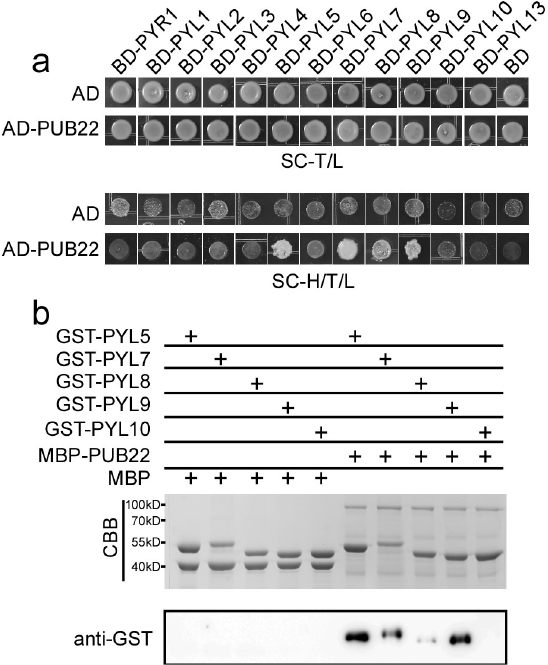
Figure 7. PUB22 interacts with PYL5, PYL7, PYL8, and PYL9. ( a ) PUB22 interacts with PYL5, PYL7, PYL8, and PYL9 in yeast two-hybrid assay. The combinations of PUB22 with different PYLs were grown on the SC medium lacking Tryptophan and Leucine (SC-T/L) or Tryptophan, Leucine and Histidine (SC-H/T/L). ( b ) PUB22 interacts with PYL5, PYL7, PYL8, and PYL9 in the pull-down assay. MBP-PUB22 and MBP bound with Amylose resin were incubated with GST-PYL5, GST-PYL7, GST-PYL8, or GST-PYL9, separately. Five percent of the input proteins were run on the PAGE gel and visualized via coomassie brilliant blue (CBB) staining (upper panel). The protein complex pulled down by resin was detected with anti-GST antibody (lower panel).